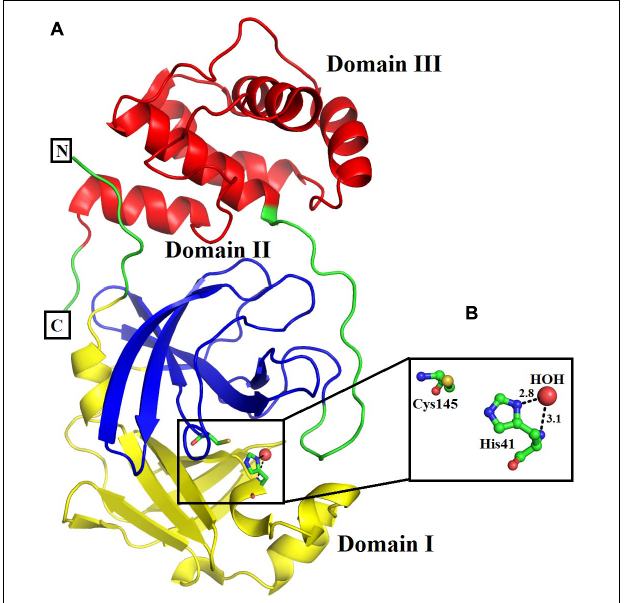
FIGURE 1 | (A) Overall three-dimensional structure of SARS-CoV-2 3CL M pro . The domains I, II, and III are colored in blue, green, and red, respectively. (B) Active site amino acid residues of SARS-CoV-2 3CL M pro . The amino acid residues are shown as balls and sticks, while the catalytic water as red